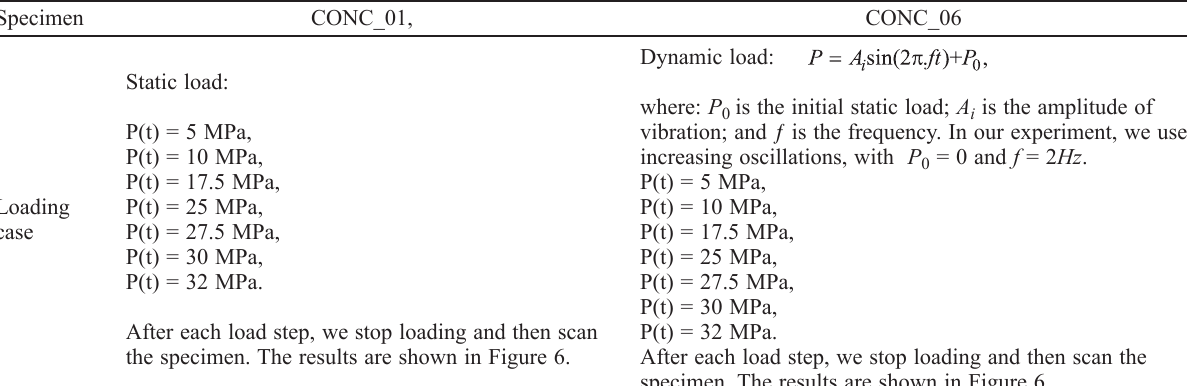
Table. Loading case Specimen